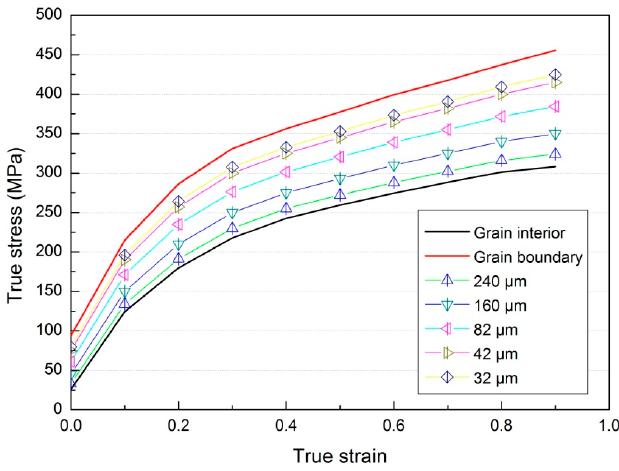
Figure 5. Strain–stress curves. Table 2. Annealing process of copper wire for different holding time under 700 °C.